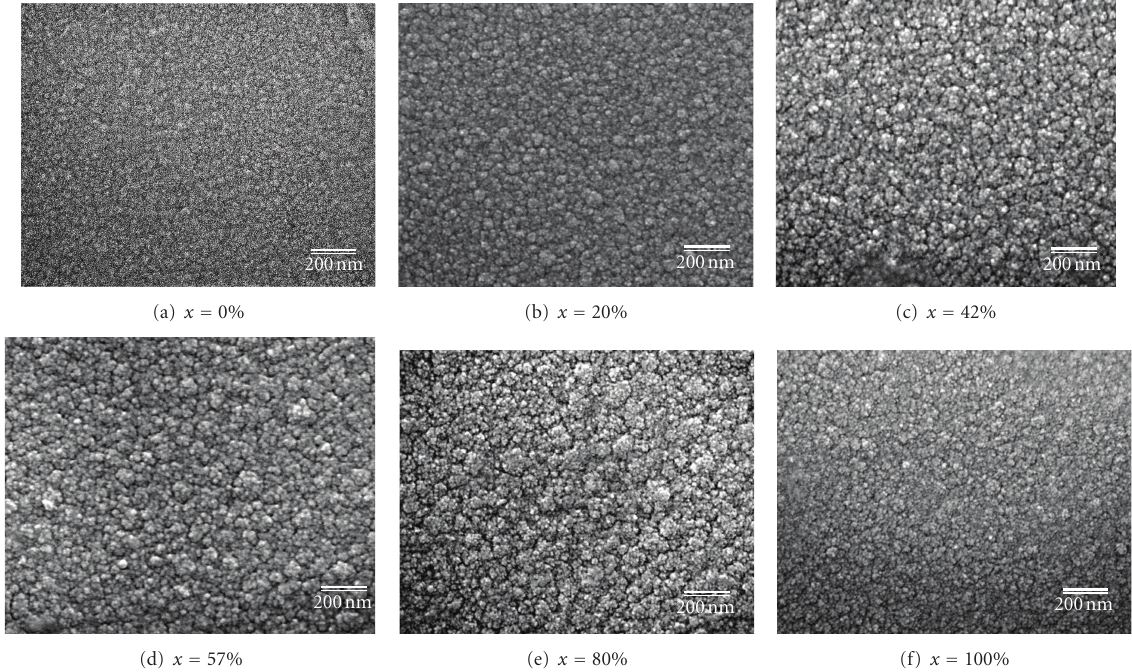
Figure 2: The SEM images of the SiGe films deposited at di ff erent gas ratios of (a) 0%, (b) 20%, (c) 42%, (d) 57%, (e) 80%, and (f) 100%.